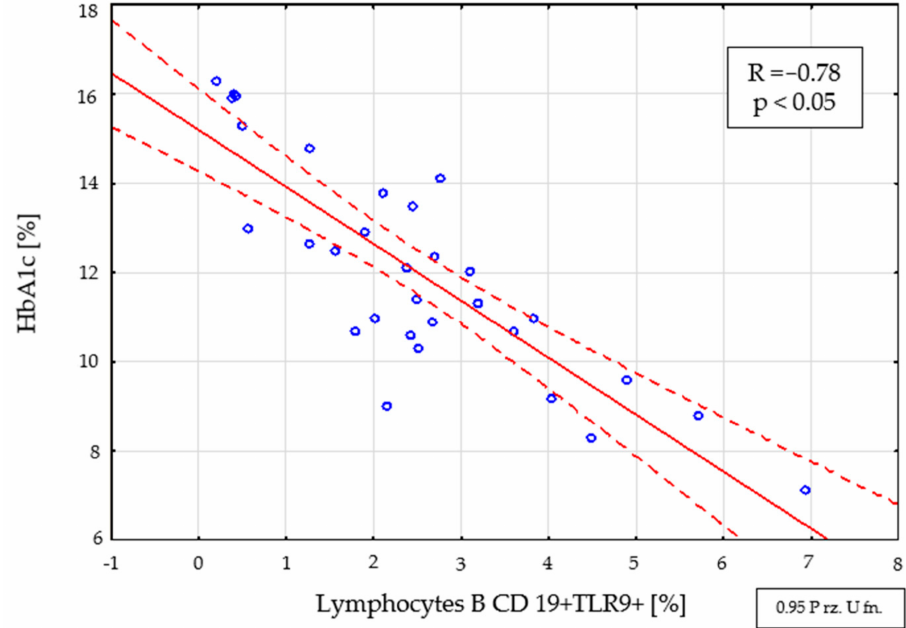
Figure 3. Relationship between the percentage of CD19+ TLR9+ B cells and the level of HbA1c in the group with newly diagnosed type 1 diabetes (<3 months from